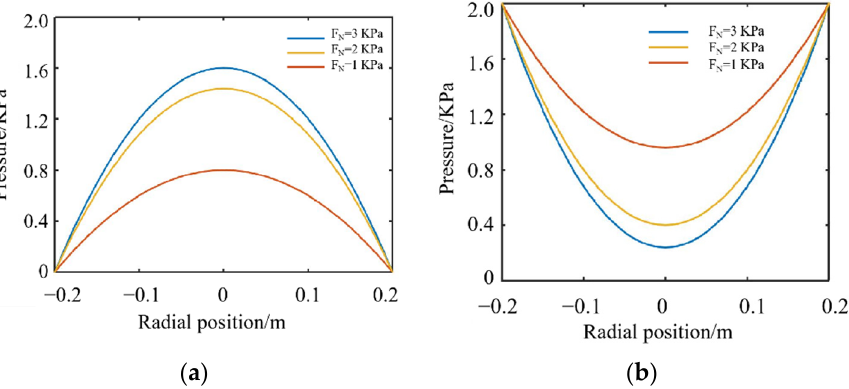
Figure 8. Distribution of liquid film pressure along horizontal direction under different external loads. ( a ) Liquid film pressure distribution ( b ) Polishing pressure distribution.